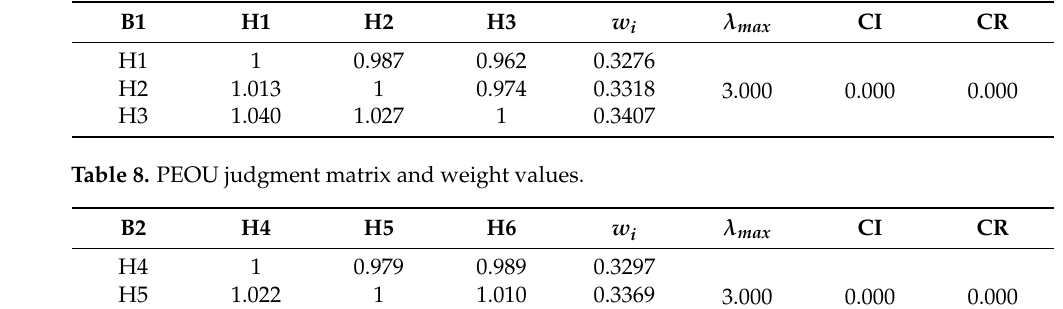
Table 7. PU judgment matrix and weight values.